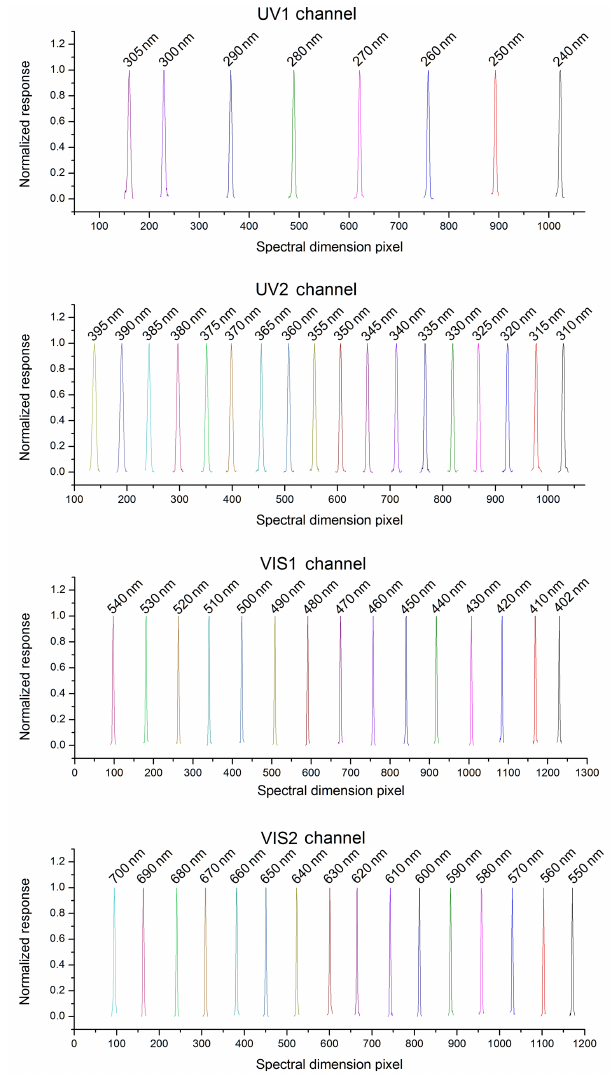
Figure 2. EMI CFOV wavelength calibration for each channel. The upper panels present the UV channel, whereas the lower panels dis- play the VIS channel. The spectral responses are normalized.